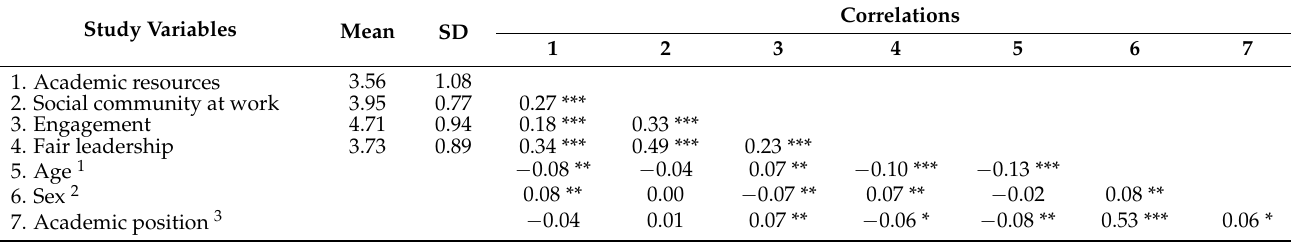
Table 1. Descriptive statistics and intercorrelations of study variables.